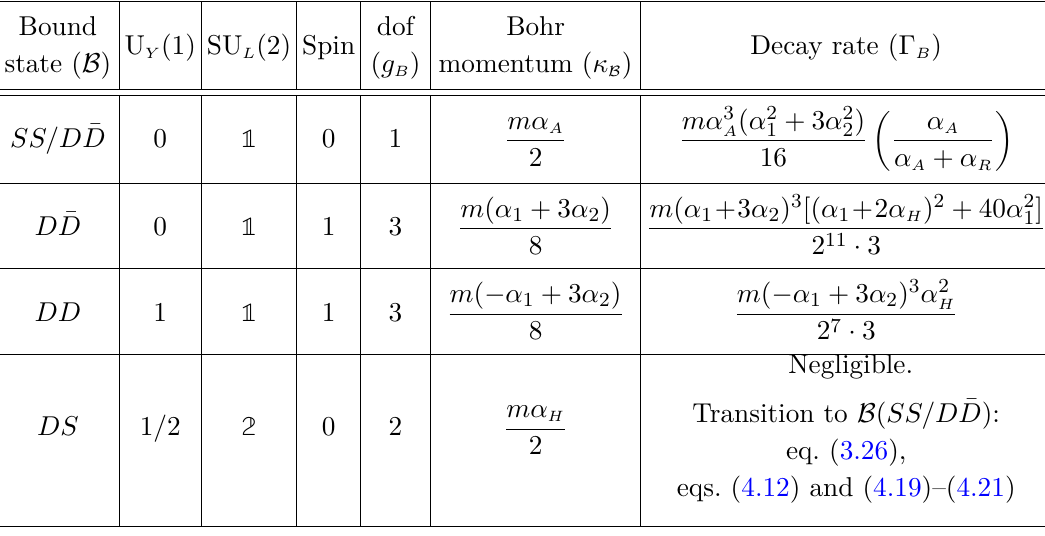
Table 6 . The ground-level bound states, { n‘m } = { 100 } , and their rates of decay into radiation, in the limit m → 0 . The decay rate of the DS bound state is suppressed, and we reference instead H the formulae for its transition rate to the SS/D ¯ D bound state. In the first row, α found from eqs. (2.25) for ‘ = s = 0 . The binding energy of each bound state is |E